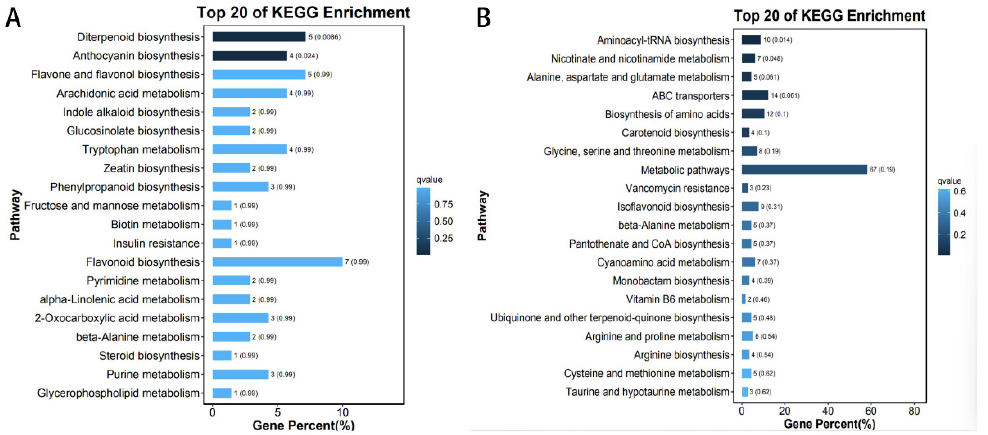
Figure 9. KO enrichment bar graph: ( A ) The 20 metabolic pathways with the lowest q-values in the brown module. ( B ) The 20 metabolic pathways with the lowest q-values in the turquoise module. The top 20 pathways with the smallest q-value are used to make the graph. The vertical coordinate is the Pathway. The horizontal coordinate is the number of that Pathway as a percentage of the number of all differences. The darker the color, the smaller the q-value, and the value on the bar is the number q-value of that Pathway.